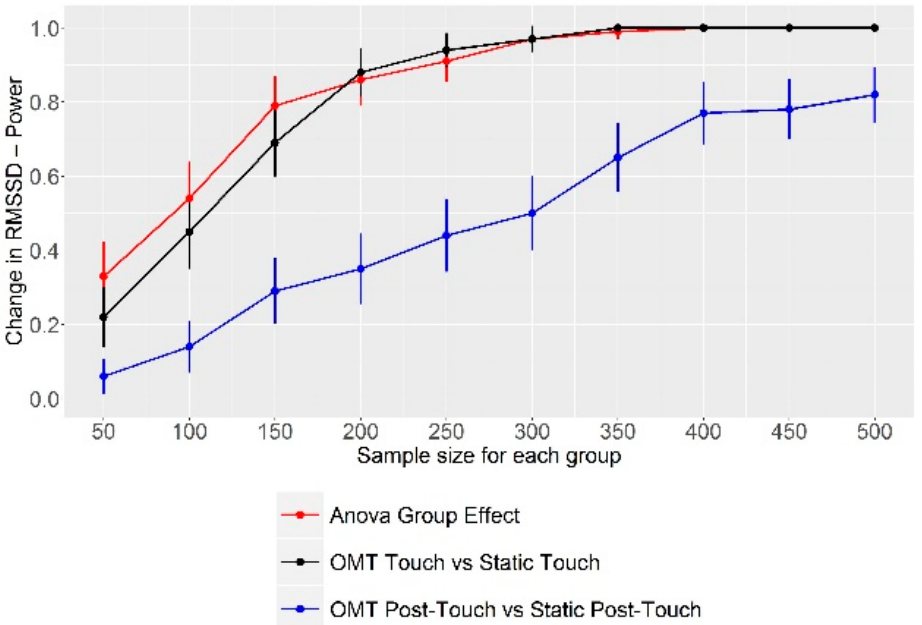
Figure 1. Power analysis via Monte Carlo simulation. The x-axis shows the sample size for each group: therefore, the total sample size for each point equals two times its corresponding x-axis value (e.g., a value of 100 on the x-axis corresponds to a total sample size of 200). For every sample size evaluated, the graph reports the power β for detecting a statistically significant change in RMSSD value: as revealed by the ANOVA group main effect; between the Dynamic Touch group and the Static Touch group during the intervention; between the Dynamic Touch group and the Static Touch group after the intervention. Abbreviations: RMSSD, root mean squared successive